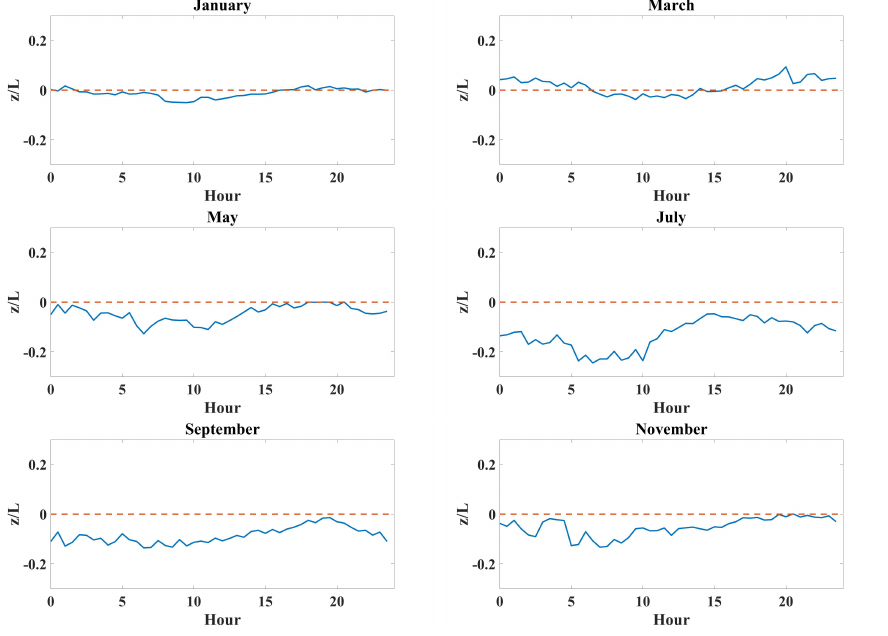
Figure 6. Diurnal stability parameter, z/L , for selected months in 2021.